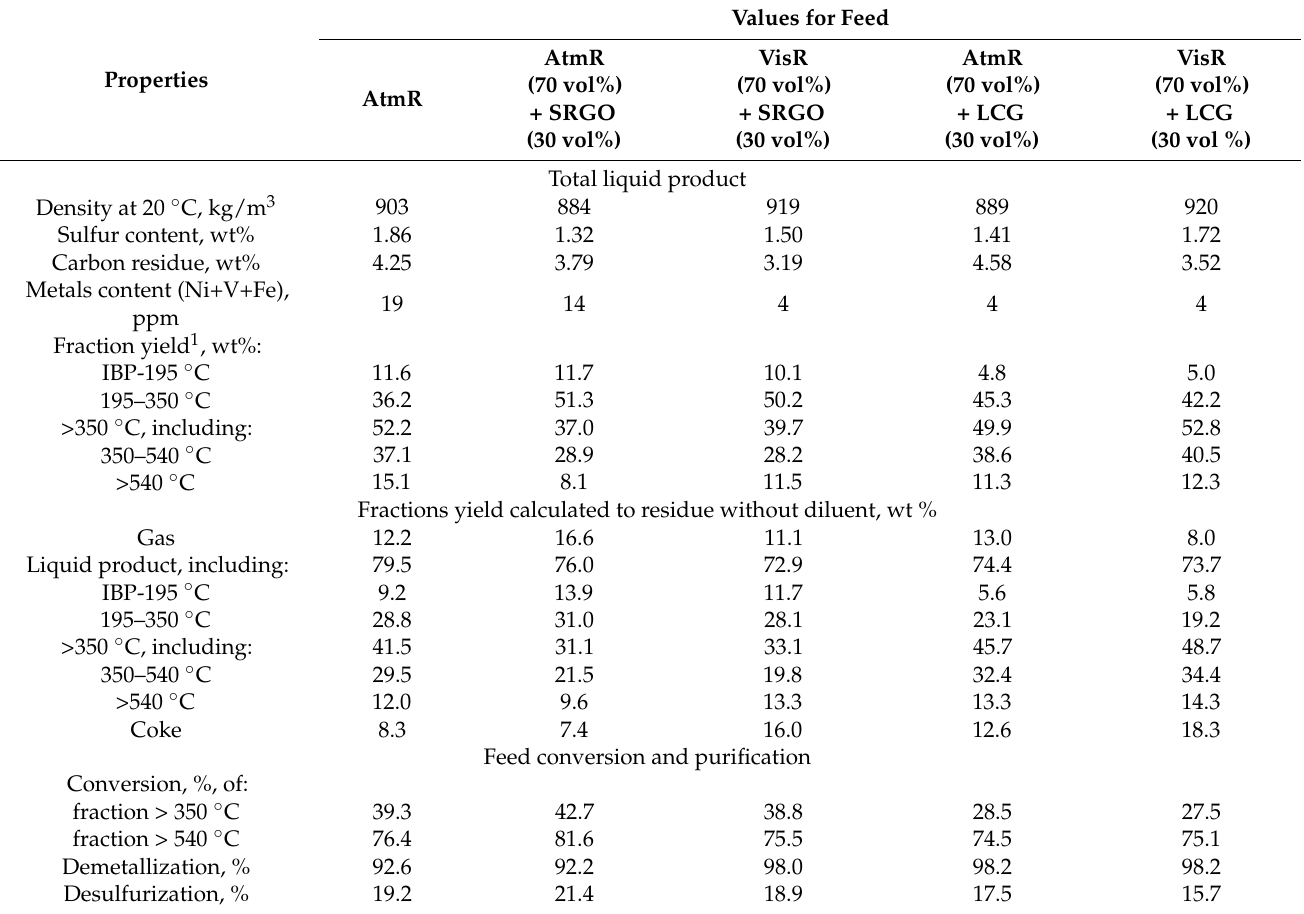
Table 3. Characteristics of the adsorptive treatment process of residual feed at 485 ◦